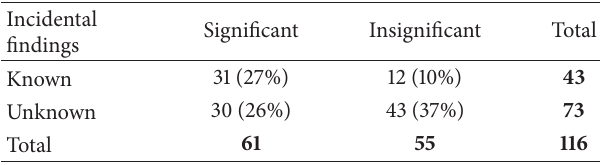
Table 5: Cumulative